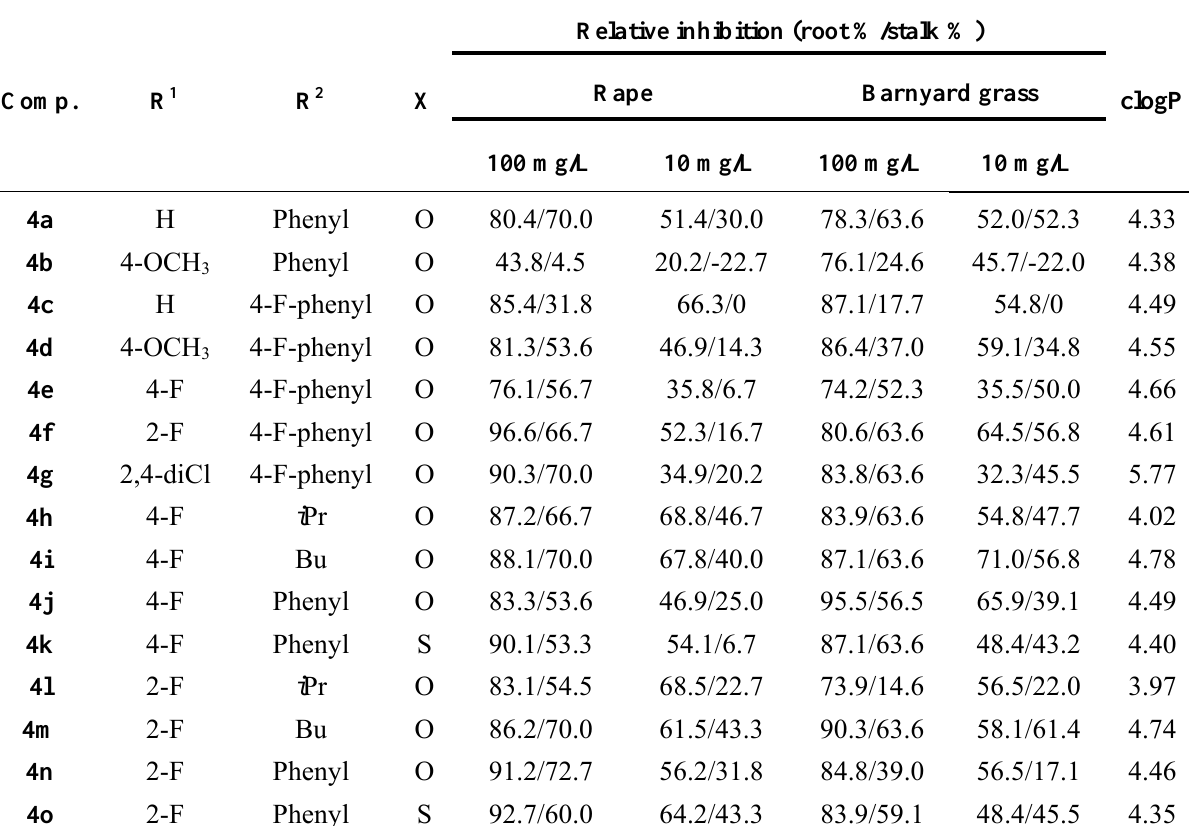
Table 2 . Herbicidal activity of the target compounds 4a ~ 4o and their logP values.